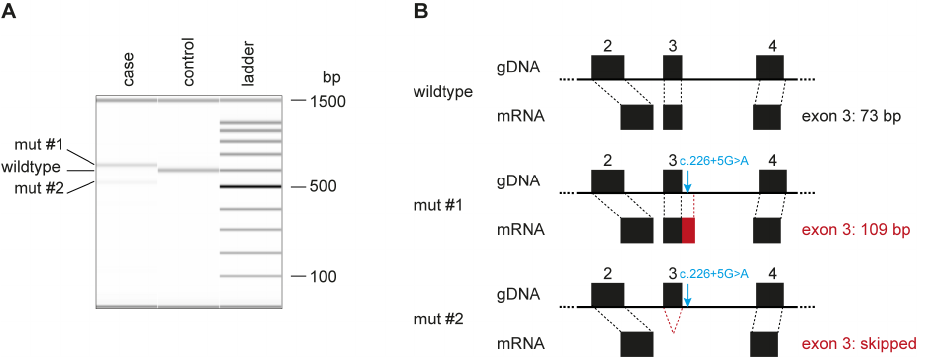
Figure 3. Aberrant CYB5R3 transcripts in the affected cat. ( A ) Fragment Analyzer bands of the RT–PCR products in the control animal show the expected 599 bp band, while in the affected animal, two different bands are visible (mut #1 and mut #2). Sanger sequencing yielded a length of 635 bp for mut #1 and 526 bp for mut #2. ( B ) Schematic representation of exons 2 to 4 of the CYB5R3 gene. The c.226+5G>A variant is indicated on the genomic DNA level with a blue arrow. The variant leads to aberrant splicing, adding 36 bp of intron 3 to the mut #1 mRNA and skipping the entire exon 3 in the mut #2